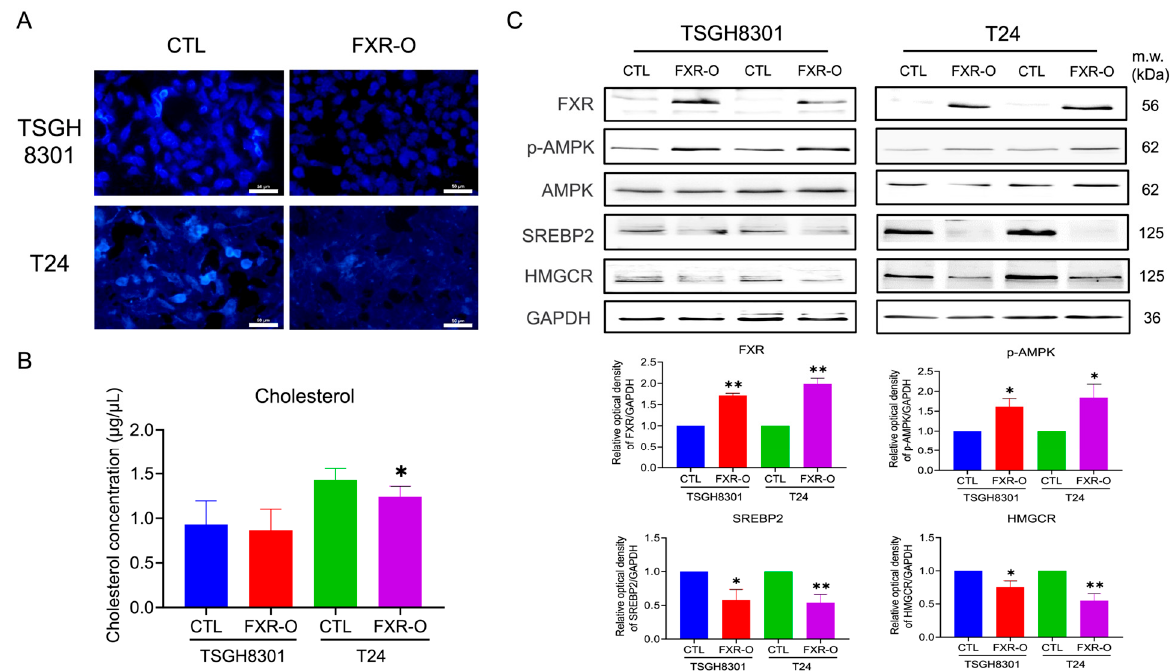
Figure 1. The effect of Farnesoid X receptor (FXR) overexpression on cholesterol content and cholesterol biosynthesis-related protein expression. ( A ) FXR was overexpressed (FXR-O) in TSGH8301 and T24 cells for 72 h, and the cholesterol content was measured by a cholesterol cell-based assay. ( B ) The level of cholesterol secreted into the conditioned medium of TSGH8301 and T24 cells was analyzed by ELISA. ( C ) FXR was overexpressed in TSGH8301 and T24 cells for 72 h, and p-AMPK, AMPK, SREBP2 and HMGCR protein expression was examined by Western blotting. GAPDH was a loading control. The relative quantitative analysis of these proteins was shown by bar graphs. * p < 0.05; ** p < 0.01 compared with the control group. Scale bar = 50 µ m. The original blots are shown in Figure